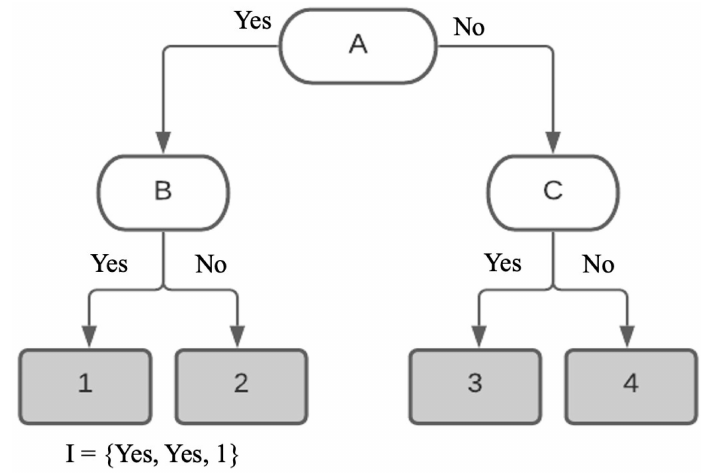
Figure 2. Example of a Decision